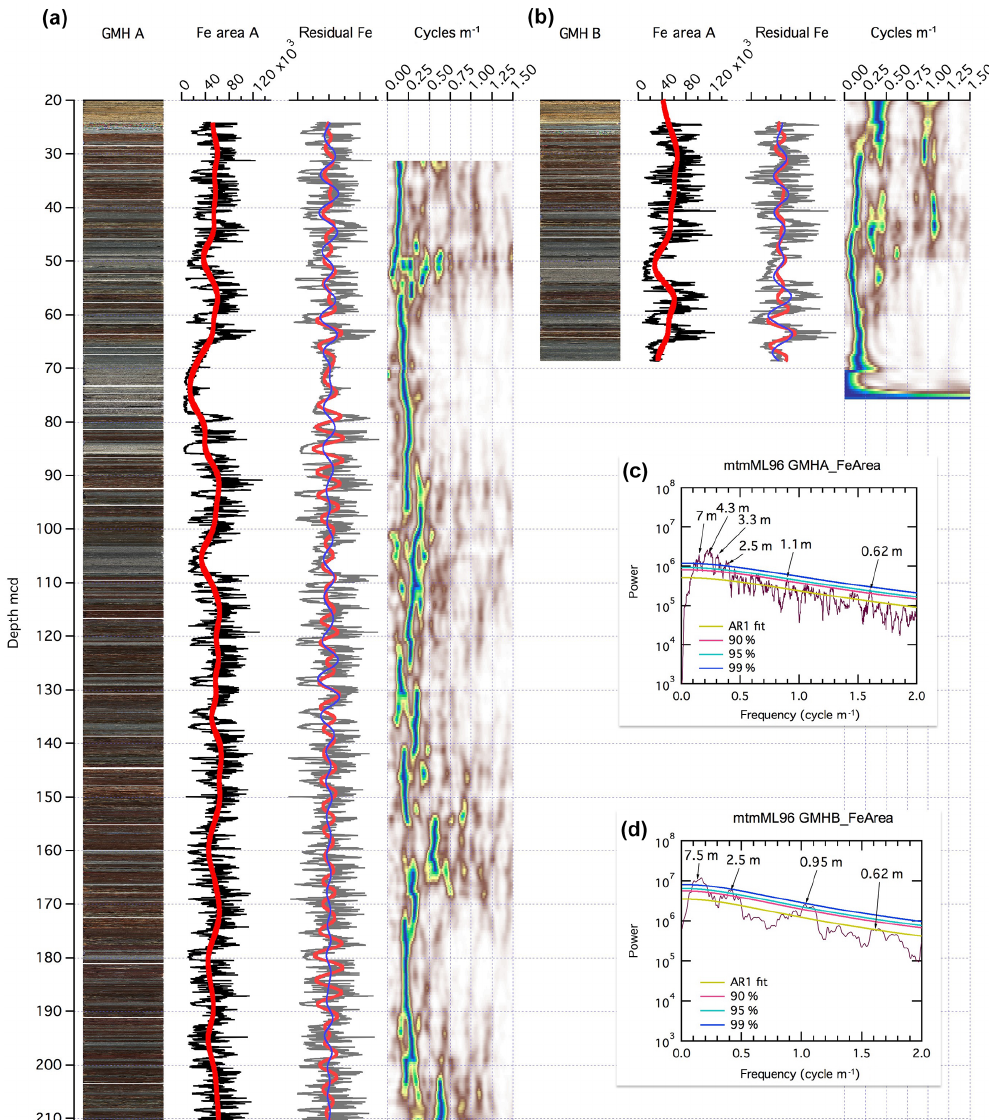
Figure 4. Gilmore Hill GMH-A (a) and GMH-B (b) core images, XRF Fe intensity data, and spectral analysis on composite depth scale. Panels (c, d) show the MTM power spectra for GMH-A and GMH-B Fe data. For details see Fig.